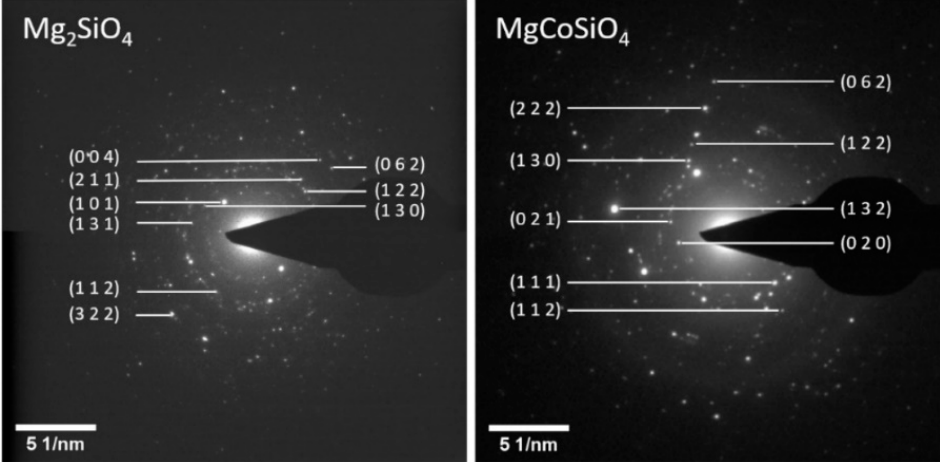
Figure 5. Selected area electron diffraction (SAED) images of synthesized Mg 2 SiO 4 ( left ) and MgCoSiO 4 ( right ).